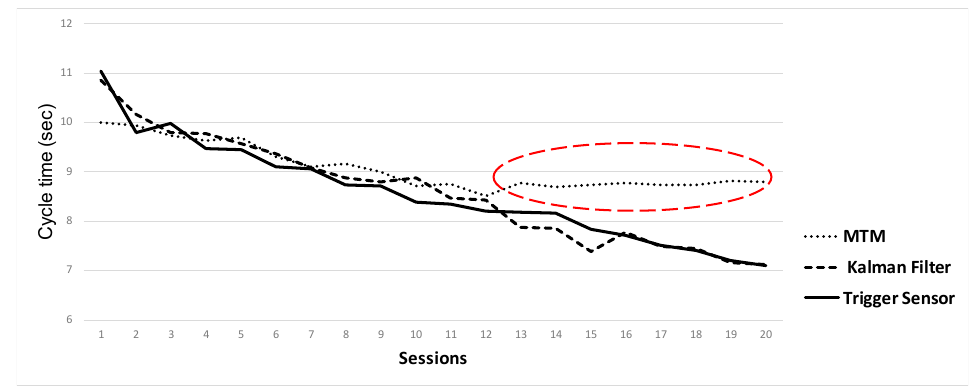
Figure 11. Cycle time over 20 sessions for different handover prediction models under the assembly learning effect.